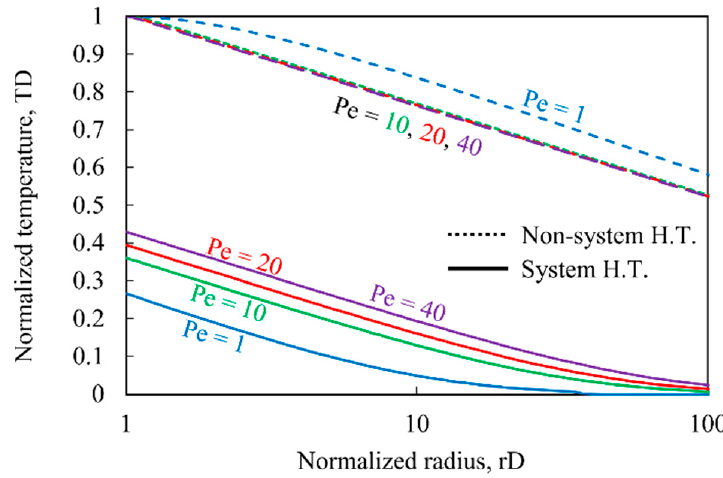
11 of 16 Figure 6. Comparison of radial temperature distribution with varying Peclet numbers. Figure 7 represents the relative contribution of system heat transfer by varying Peclet numbers 1, 10, 20, and 40. To show the relative contribution effectively, we normalize the temperature with respect to the wellbore wall temperature from the non-system H.T. model. When compared with the temperature at the wellbore wall (i.e., r D = 1), the system